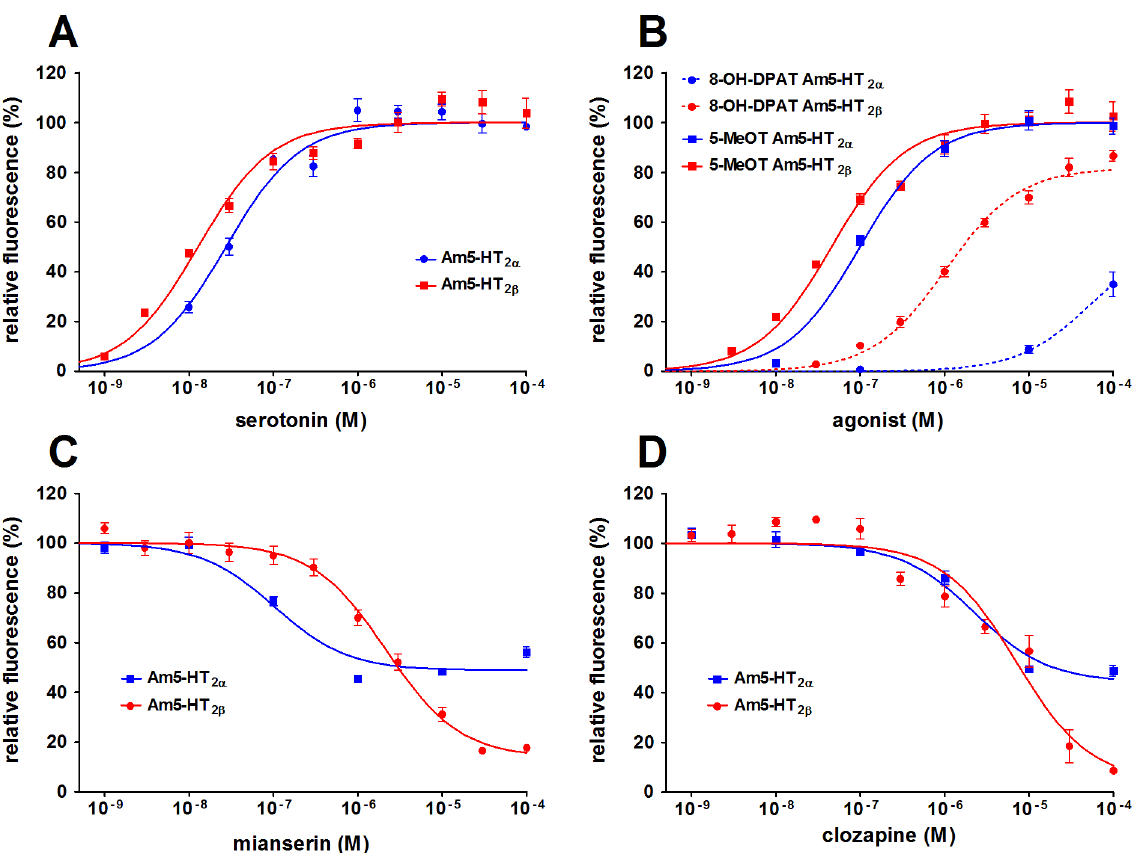
Figure 6. Concentration-dependent effects of agonists and antagonists on [Ca 2 + ] i in Am5-HT 2 a - and Am5-HT 2 b -expressing HEK 293 cells. [Ca 2 + ] i is depicted as relative fluorescence given in percent. Data represent the mean 6 SEM of eight replicates from one experiment representative of at least two similar experiments. (A) Am5-HT 2 a - or Am5-HT 2 b -expressing cells were incubated with increasing concentrations of serotonin. Values were normalized to the response measured at the highest serotonin concentration (=100%) for each cell line. (B) Cells expressing Am5-HT 2 a or Am5-HT 2 b were incubated with increasing concentrations of the agonists 5-methoxytryptamine (5-MeOT) and 8-hydroxy-DPAT (8-OH- DPAT). Values were normalized to the response measured at the highest 5-MeOT concentration (=100%) for each cell line. (C, D) Cells expressing Am5-HT 2 a or Am5-HT 2 b were incubated with 50 nM serotonin and increasing concentrations of the antagonist mianserin (C) or clozapine (D). Values were normalized to the serotonin response in the absence of antagonist (=100%).